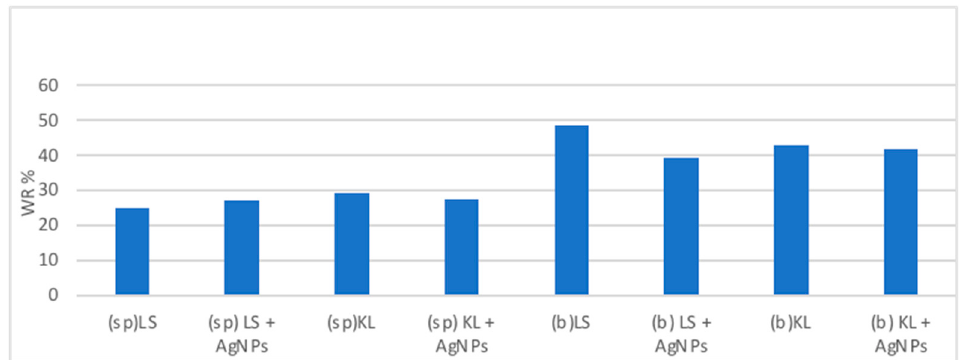
Figure 2. Weight retained percentage (WR%) after application of treatments, sp: Scots pine, b: beech, LS: Lignin sulfonate; KL: Kraft lignin, AgNPs: silver nanoparticles.